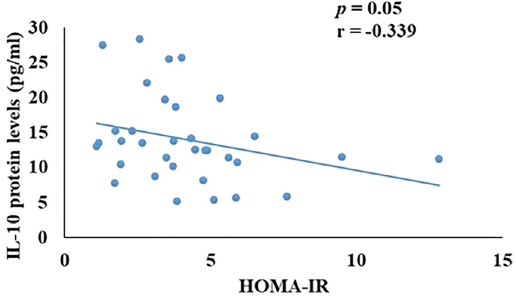
Figure 3: Correlation of serum IL-10 levels with HOMA-IR in patients with